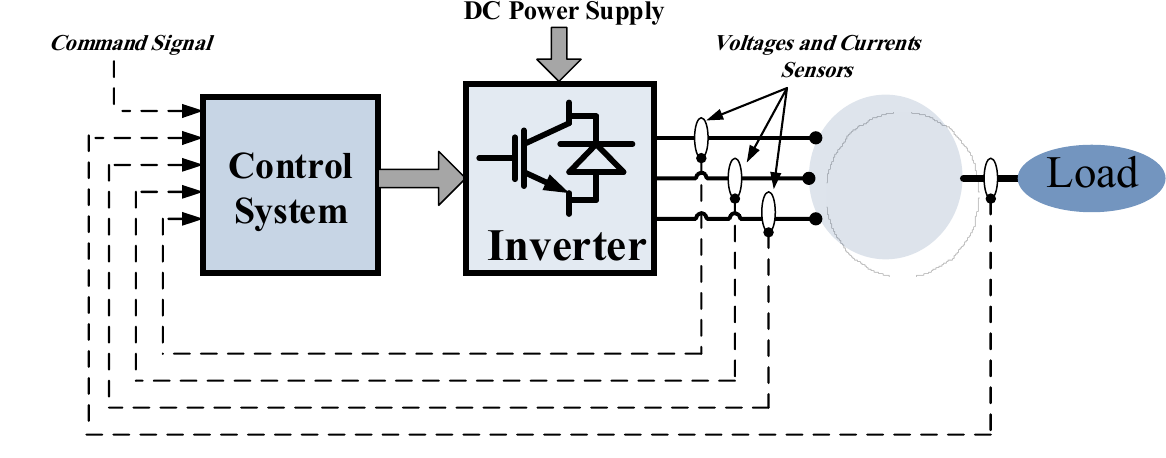
Figure 1. IM control system design.